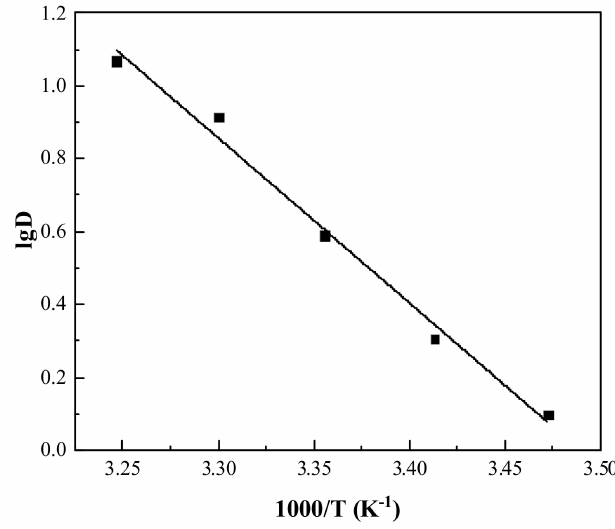
Figure 11. Effect of temperature on P204 extraction of Y 3+